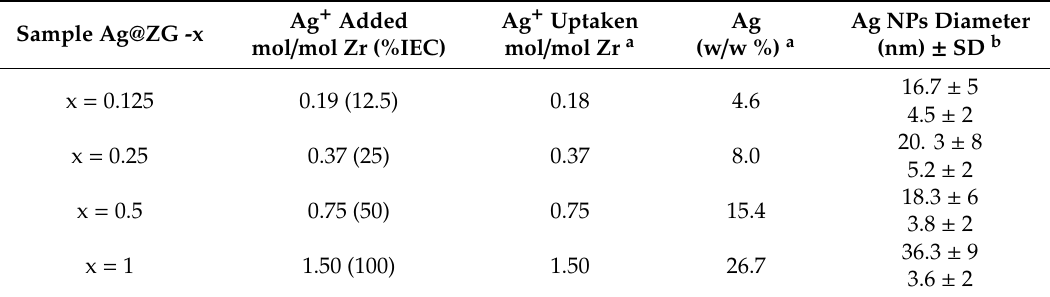
Table 1. Silver added and uptaken per mol of zirconium of ZG (IEC = 3.67 mequiv / g); weight percentage of silver in the Ag@ZG composites; Ag NPs dimensions measured by